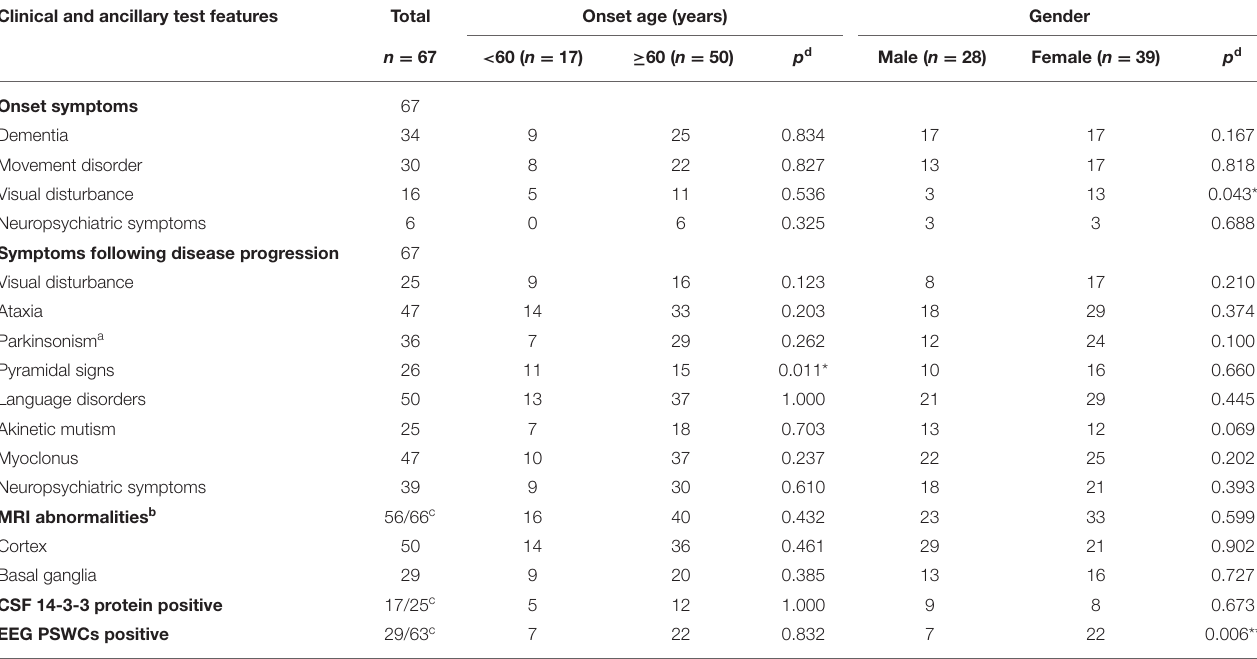
TABLE 2 | The main clinical and ancillary test features of sCJD patients. Clinical and ancillary test features